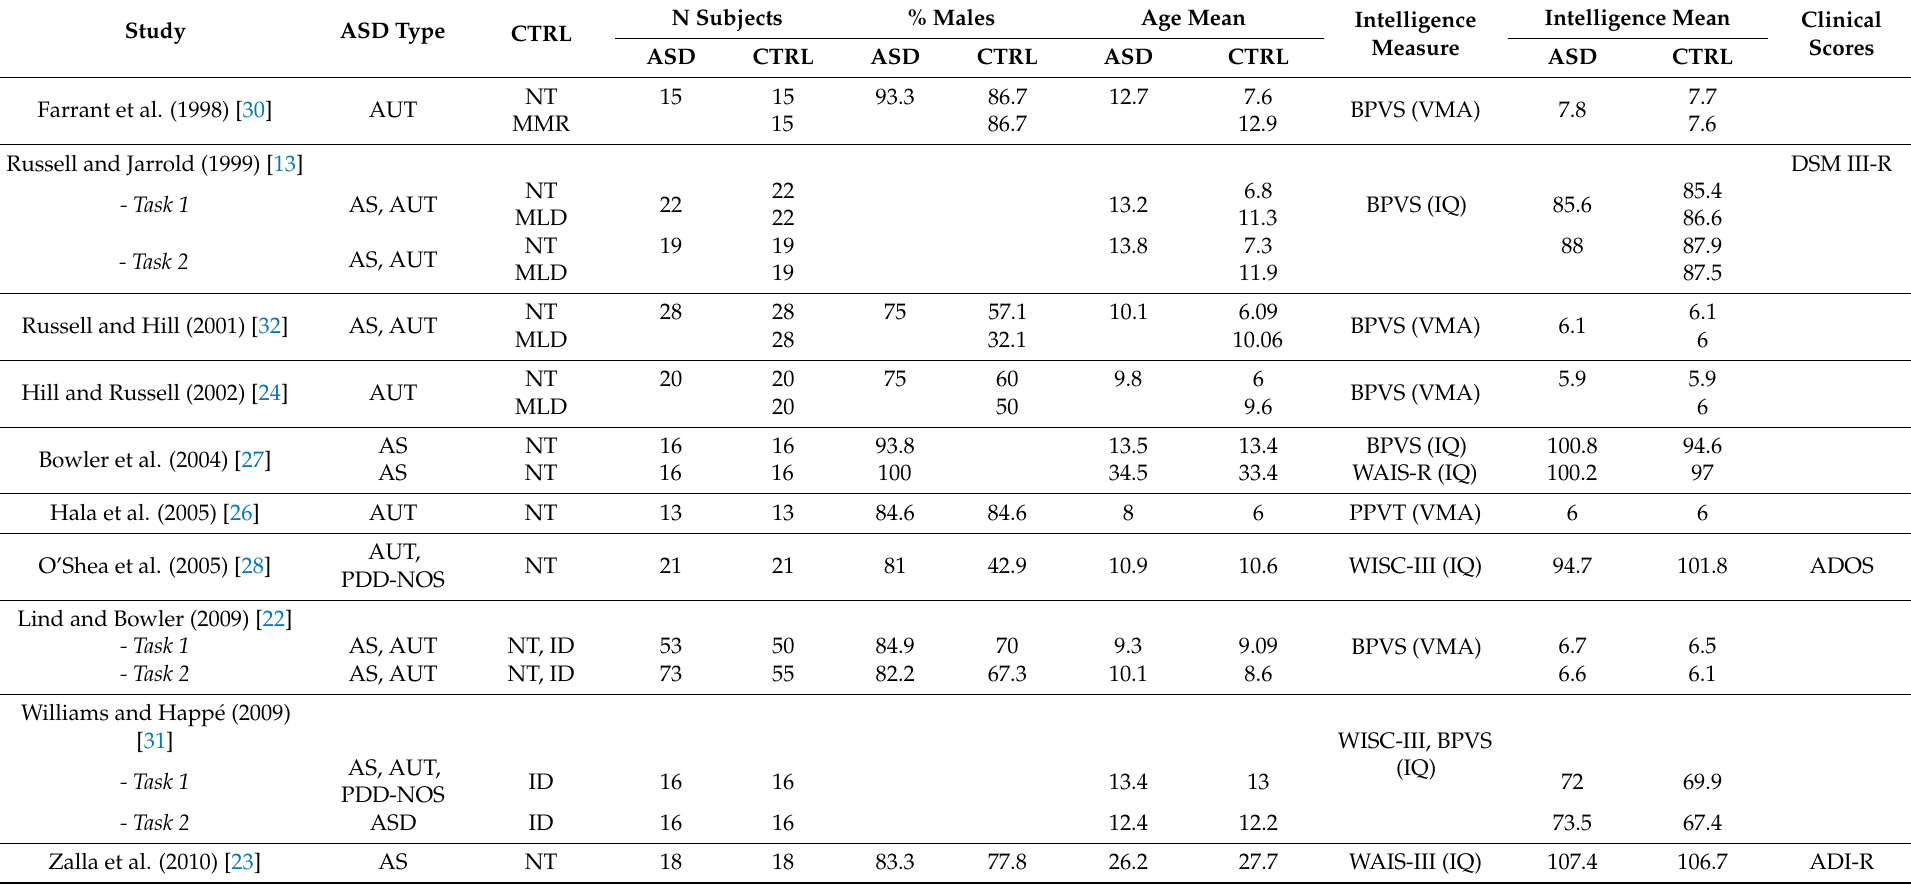
Table 3. Study characteristics and